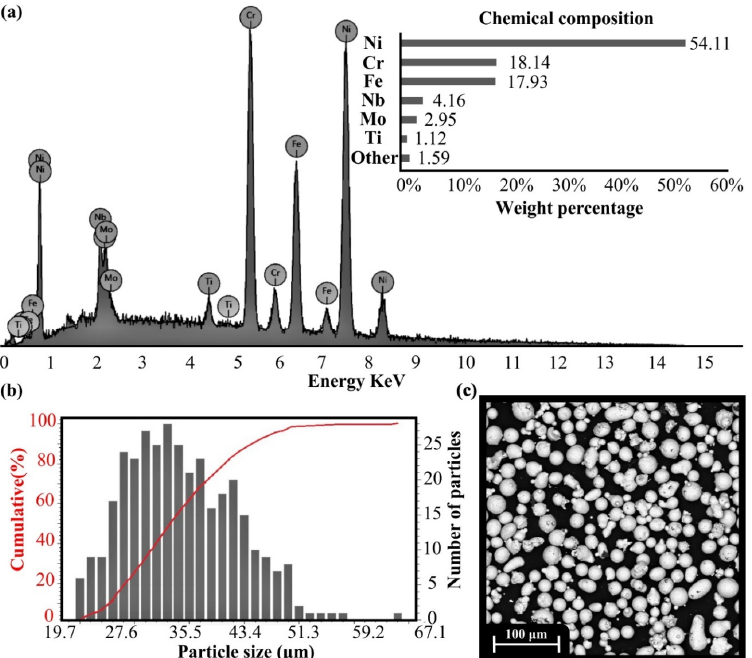
Figure 3. ( a ) EDX analysis and chemical composition; ( b ) PSD analysis; ( c ) SEM image for Inconel 718 powder.